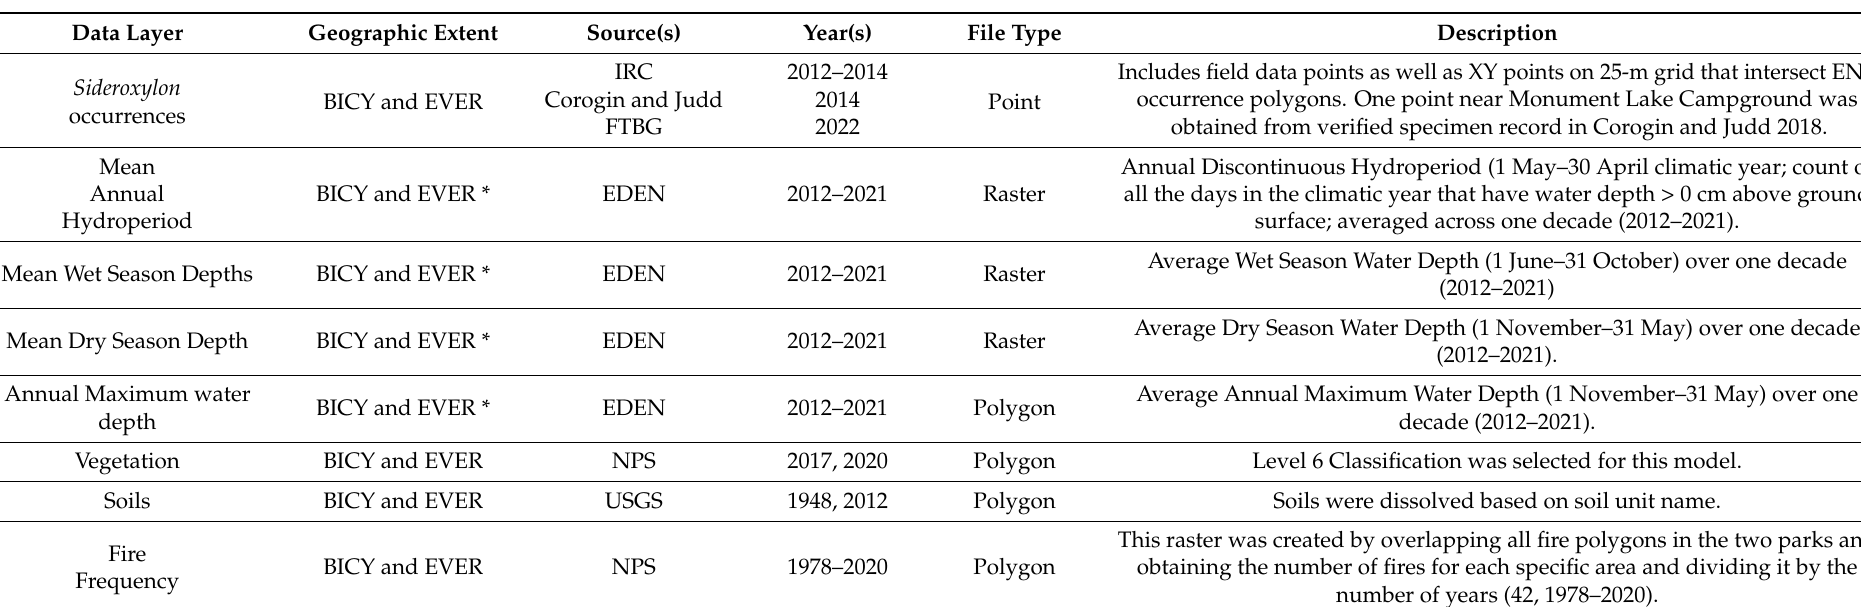
Table 2. Data layers used for MaxEnt modeling with geographic extent, source, year(s), file type, and additional comments. * The spatial extent of these layers was limited to that of the USGS EDEN